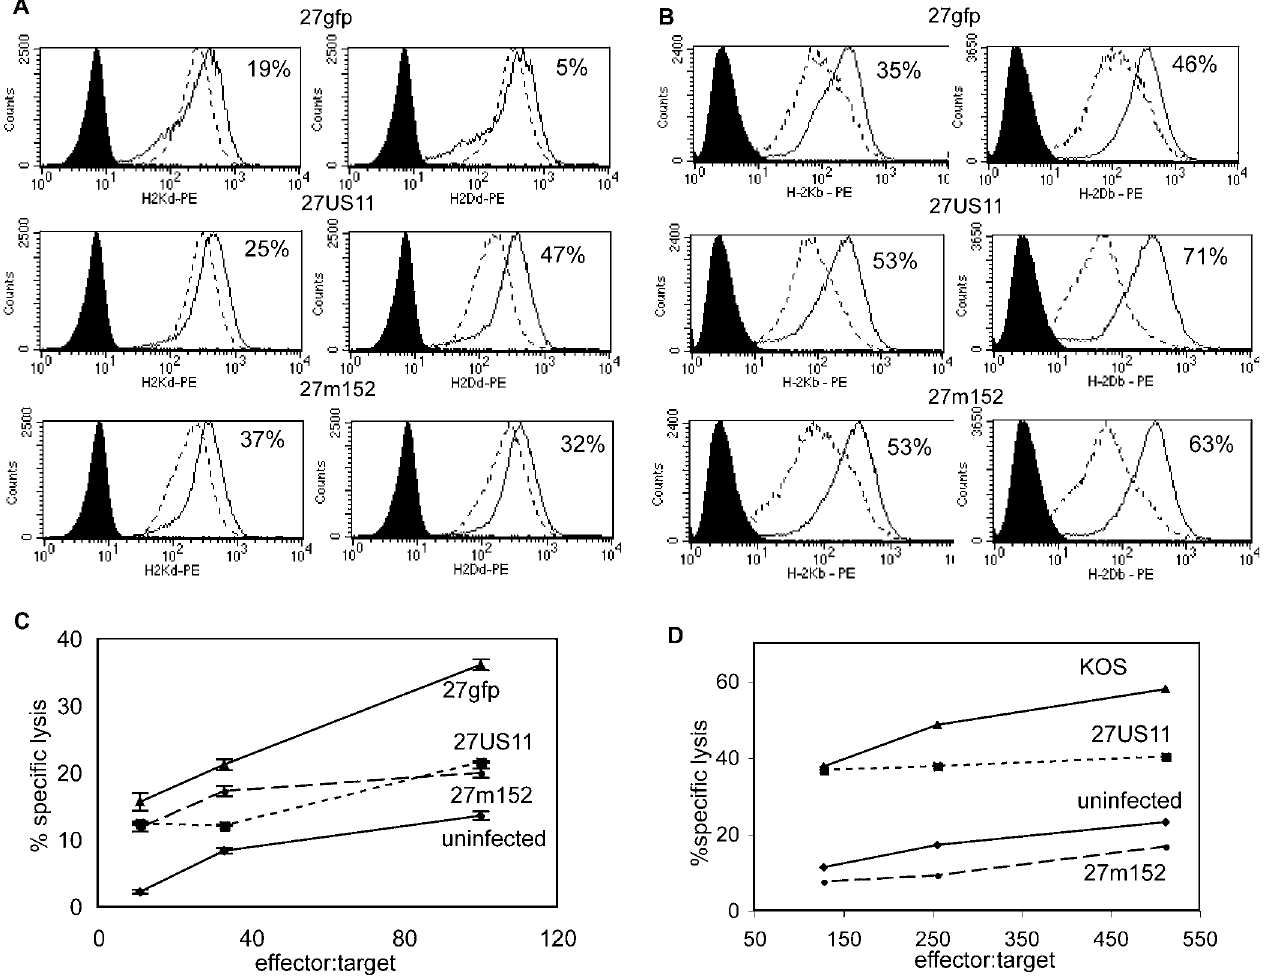
Figure 2. 27US11 and 27m152 Inhibit Murine MHC Class I Preventing Lysis by HSV-Specific CTL (A) K-BALB (H-2 d ) and (B) MC57G (H-2 b ) fibroblast cell lines were uninfected (solid line) or infected (dashed line) at an MOI of 5:1 with 27gfp, 27US11, or 27m152 for 18 h and analyzed for surface MHC class I expression. Filled histograms are isotype controls. The percentage reduction in mean fluorescent intensity from uninfected to infected cells is indicated. (C) and (D) Cells were infected as for (A) and (B) and co-incubated with CTL isolated from HSV-infected (C) BALB/c or (D) BALB.B mice at the